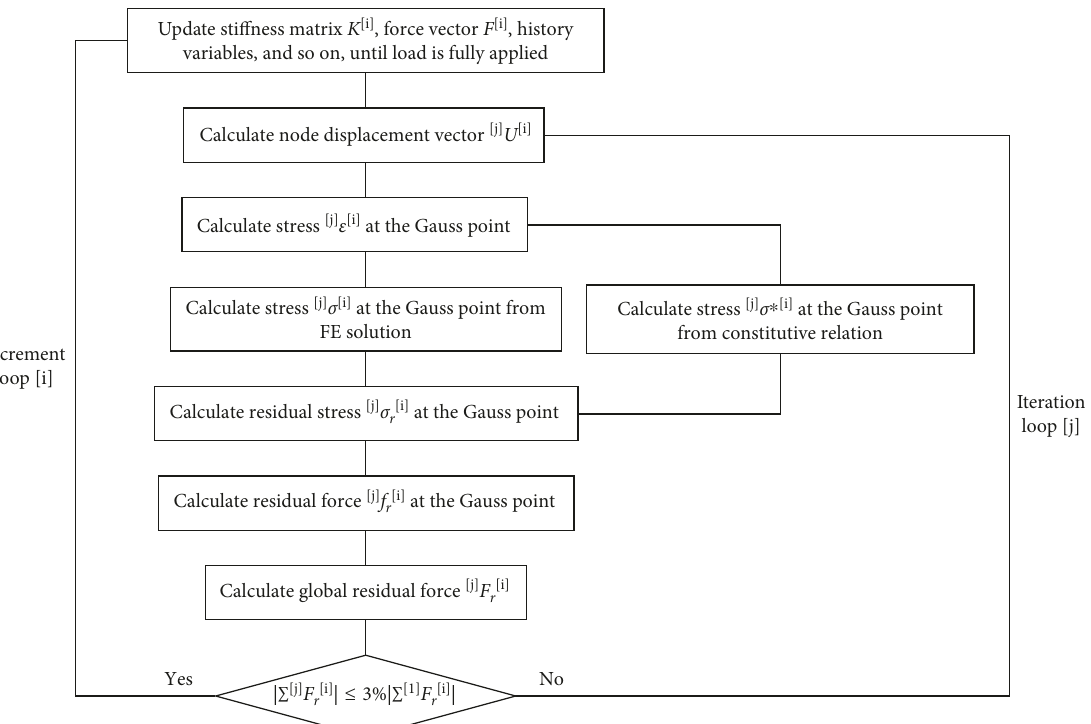
Figure 5: The flowchart of the recursive-iterative algorithm.